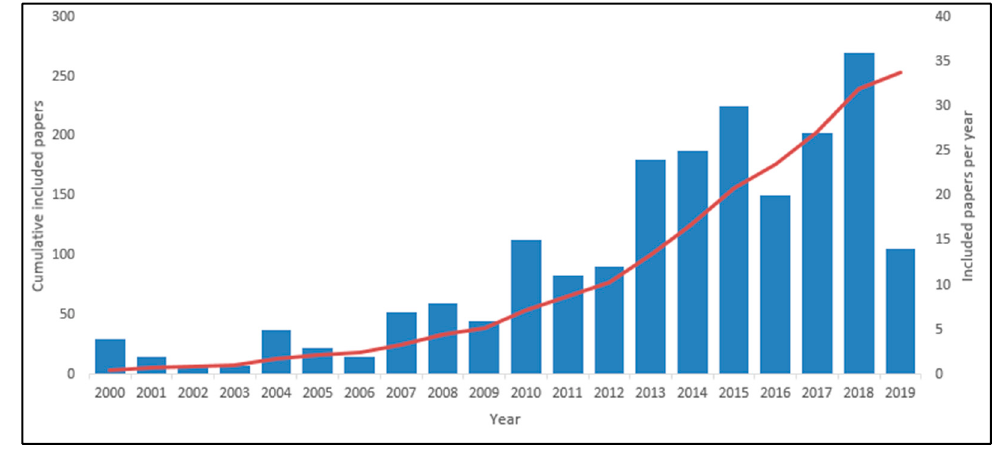
Figure 2. Included papers per year.